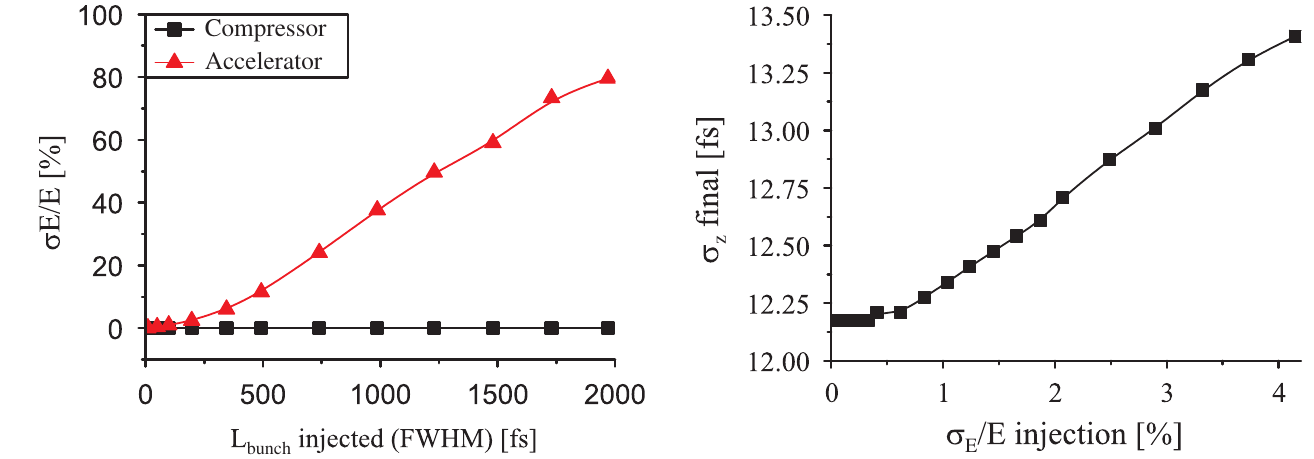
FIG. 9. (Color) Energy spread after compression as a function of the length of the injected bunch for both the compressor and accelerator